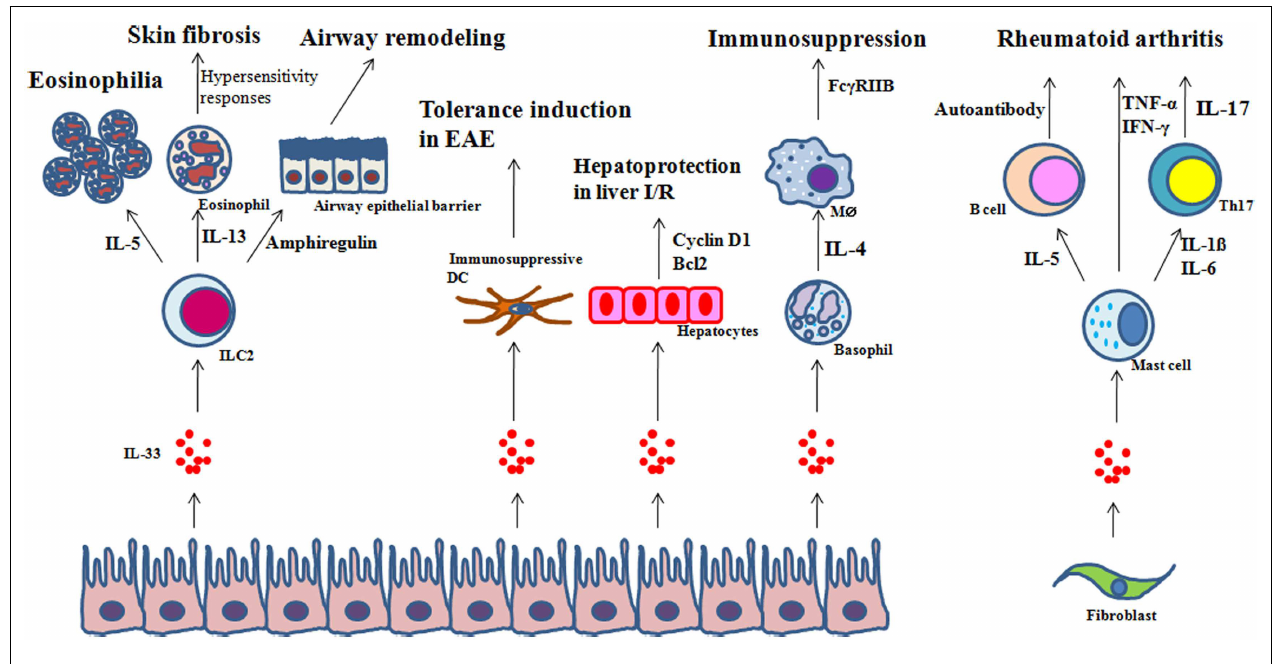
ischemia/reperfusion (I/R); (4) basophils secrete IL-4 which in turn promotes the expression of the inhibitory Fc γ RIIB on effector macrophages; and (5) mast cells produce IL-5, and IL-1 β and IL-6 which are involved in autoantibody production by autoreactive B cells andTh17 differentiation, respectively, in rheumatoid